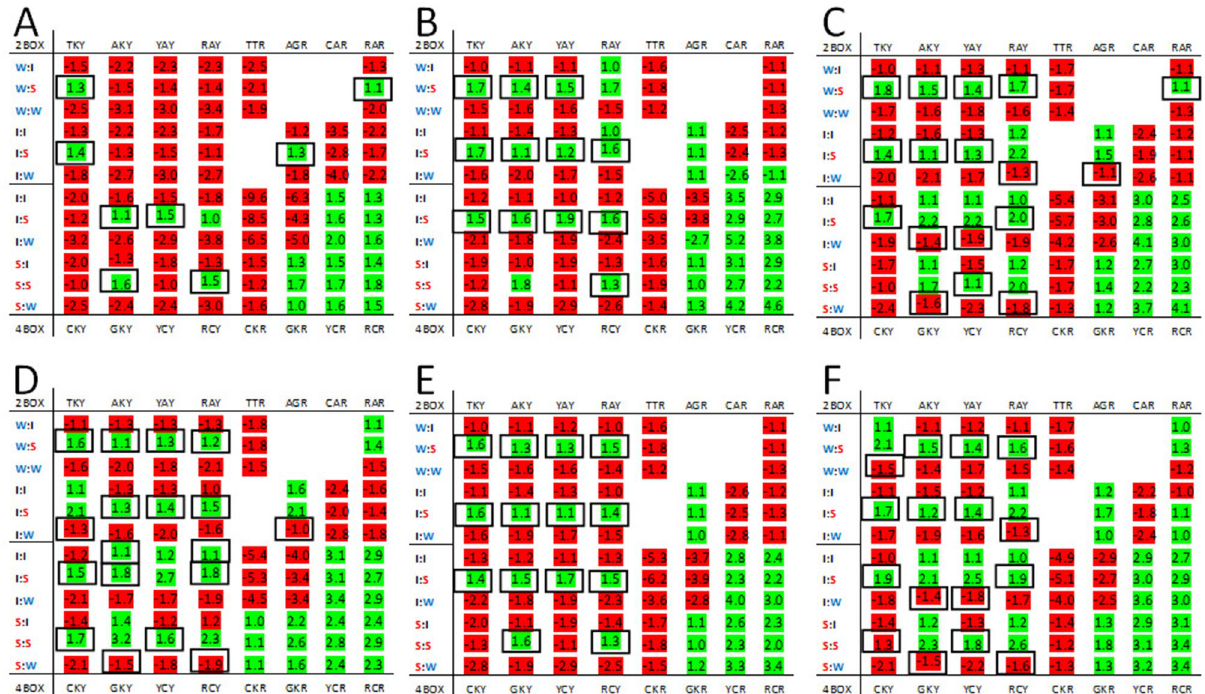
Figure 5. Heatmaps for Takifugu rubripes (pufferfish) and Danio rerio (zebrafish) ( A and D ), Homo sapiens (human) and Myotis lucifugus (brown bat) ( B and E ), and Gallus gallus (chicken) and Columba livia (pigeon) ( C and F ). Features of the heatmaps are described in the “Methods” section. Black boxes indicate cells with biases opposite of the expected and with a frequency greater than 1.05 for either observed or expected ratio.